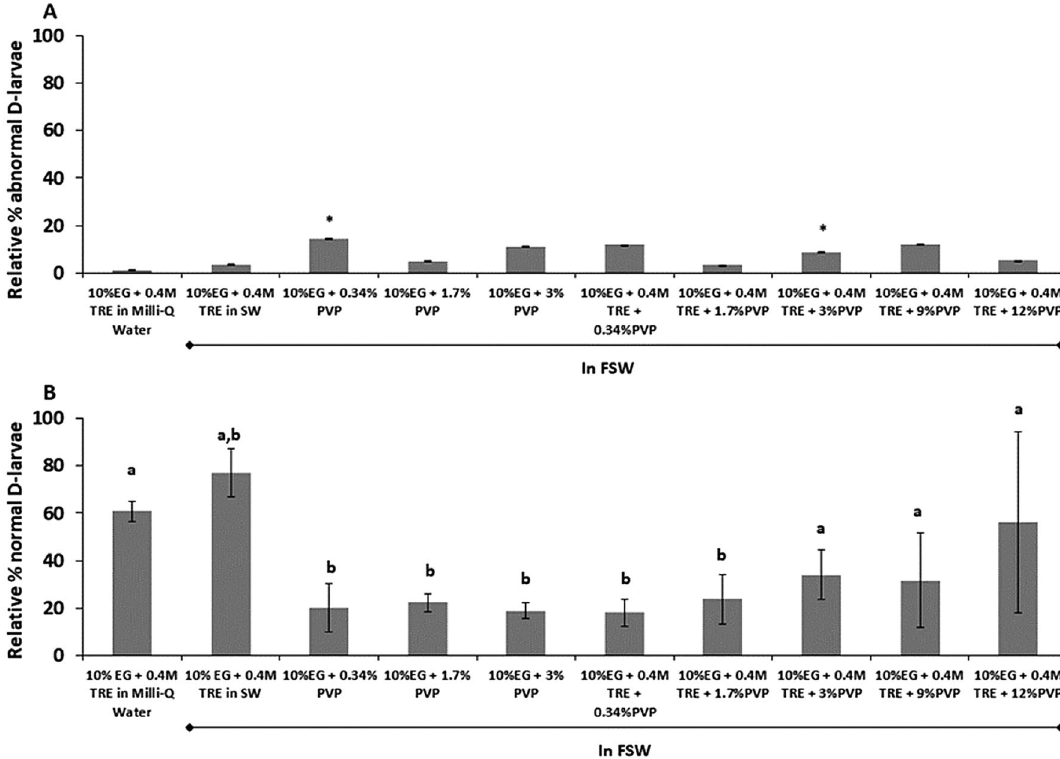
Figure 2. Cryopreservation experiments with Mytilus galloprovincialis 72 h-old D-larvae to test the effect of different CPA combinations. ( A ) Relative percentage of abnormal D-larvae compared to the control group developed 48 h from 72 h-old D-larvae exposed for 60 min to different cryoprotecting combinations of Ethylene–Glycol (EG), trehalose (TRE) and Polyvinylpyrrolidone (PVP) in Filtered Sea Water (FSW) or Milli-Q Water in 72 h-old D-larvae (% of abnormal larvae in controls: 15 ± 9.29). ( B ) Percentage of 72 h-old D-larvae developing to normal D-larvae following cryopreservation. Cryopreservation success was assessed as the average percentage of normal D-larvae after 48 h post cryopreservation in comparison to control group (Mean ± Standard Deviation (SD), n = 100, 3 replicates per treatment). Asterisks or letters show significant differences between control group and treatments. Different letters or asterisks show significant differences with p < 0.05 and in all cases lower % of normal larvae than controls (93 ± 6.33%).